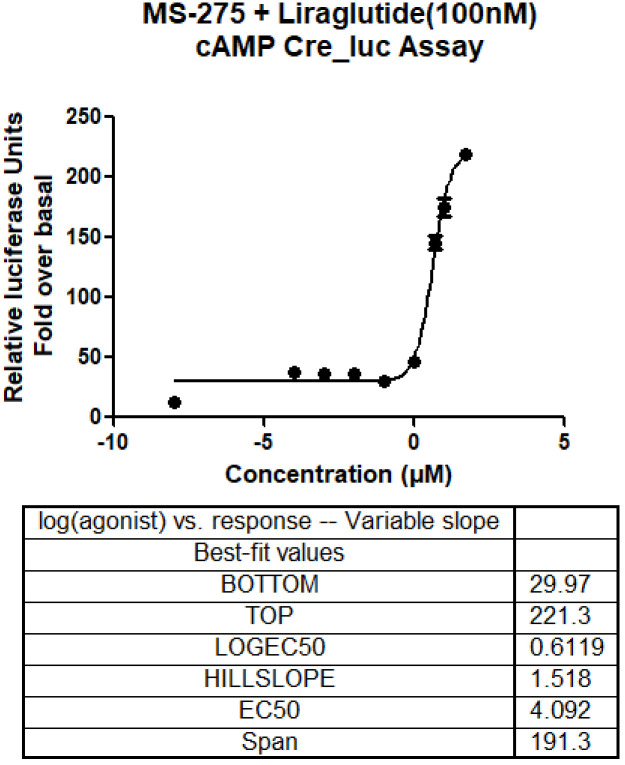
Dose-response curve depicting the role of MS-275 on GLP-1R-mediated cAMP generation.